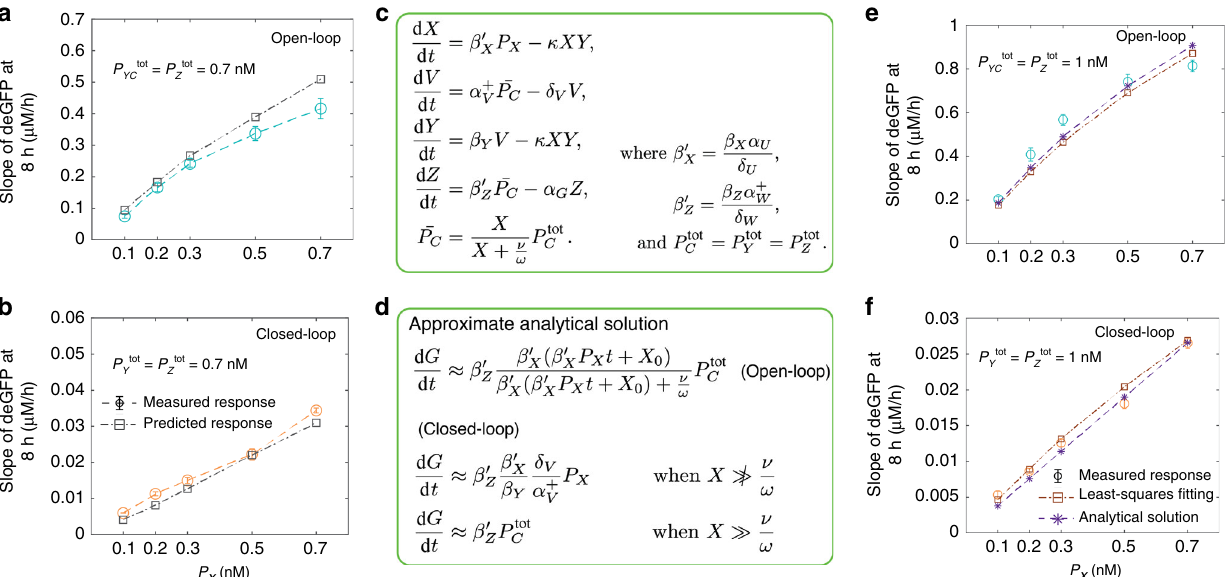
Fig. 4 Validation of the controller model and simpli fi cation. a, b Predicting the a open-loop and b closed-loop controller response for a step change in P X . P – 0.7 nM) after 2 h of incubation in the presence of initial 0.7 nM of P tot P tot X was increased from 0 nM to different concentrations (0.1 Y and Z each. (Recall that fi tting was done under different conditions, namely 1 nM of P YC tot (or P tot Y ) and P tot Z each.) The ODE model shown in Fig. 3b was used to determine the response with parameters shown in Table 1. c Simpli fi ed ODE model of the controller. d Approximate analytical solution for deGFP slopes (time derivative of G ) for the open and closed-loop cases. e , f Comparing the measured responses of the controller shown in Fig. 3c, d with the response determined using the approximate analytical solution for the e open-loop and f closed-loop cases respectively. The data shown in Fig. 4a, b are compared with the analytical solution results in Supplementary Fig. 15. Before calculating deGFP slopes, measured deGFP responses were smoothed-out using the rloess smoothing method in MATLAB. Error bars are from the SEM of at least three repeats. Source data are provided as a Source Data fi